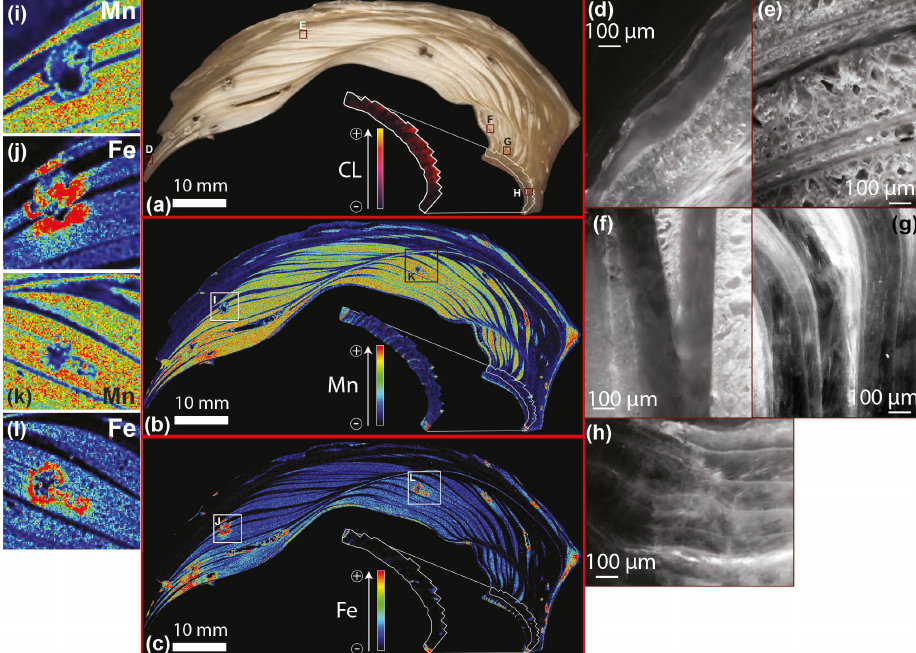
Figure 3. Overview of the results of colour scanning, microscopic analyses and µ XRF mapping of specimen M11. (a) Colour scan of cross section in growth direction through the shell, with close-up of cathodoluminescence microscopic image of the hinge line. (b) µ XRF mapping of Mn the cross section, with close-up of the µ XRF map of the hinge line. (c) µ XRF mapping of Fe the cross section, with close-up of the µ XRF map of the hinge line. (d) Micrograph of transitions between foliated and vesicular calcite near the edge of the shell. Note the blocky calcite crystals in the vesicular microstructure. (e) Micrograph of thin, alternating layers of foliated and vesicular calcite. (f) Micrograph showing sharp transitions between dense, foliated calcite and porous vesicular calcite. (g) Micrograph of gradual transitions between foliated calcite and vesicular calcite closer to the hinge. (h) Micrograph of dense, foliated calcite layers in shell hinge line. Note the thin layer of vesicular calcite (white) intercalated between the foliated layers near the bottom of the image. (i–l) Close-ups of µ XRF mapping of bore holes with coronas of elevated Fe and Mn